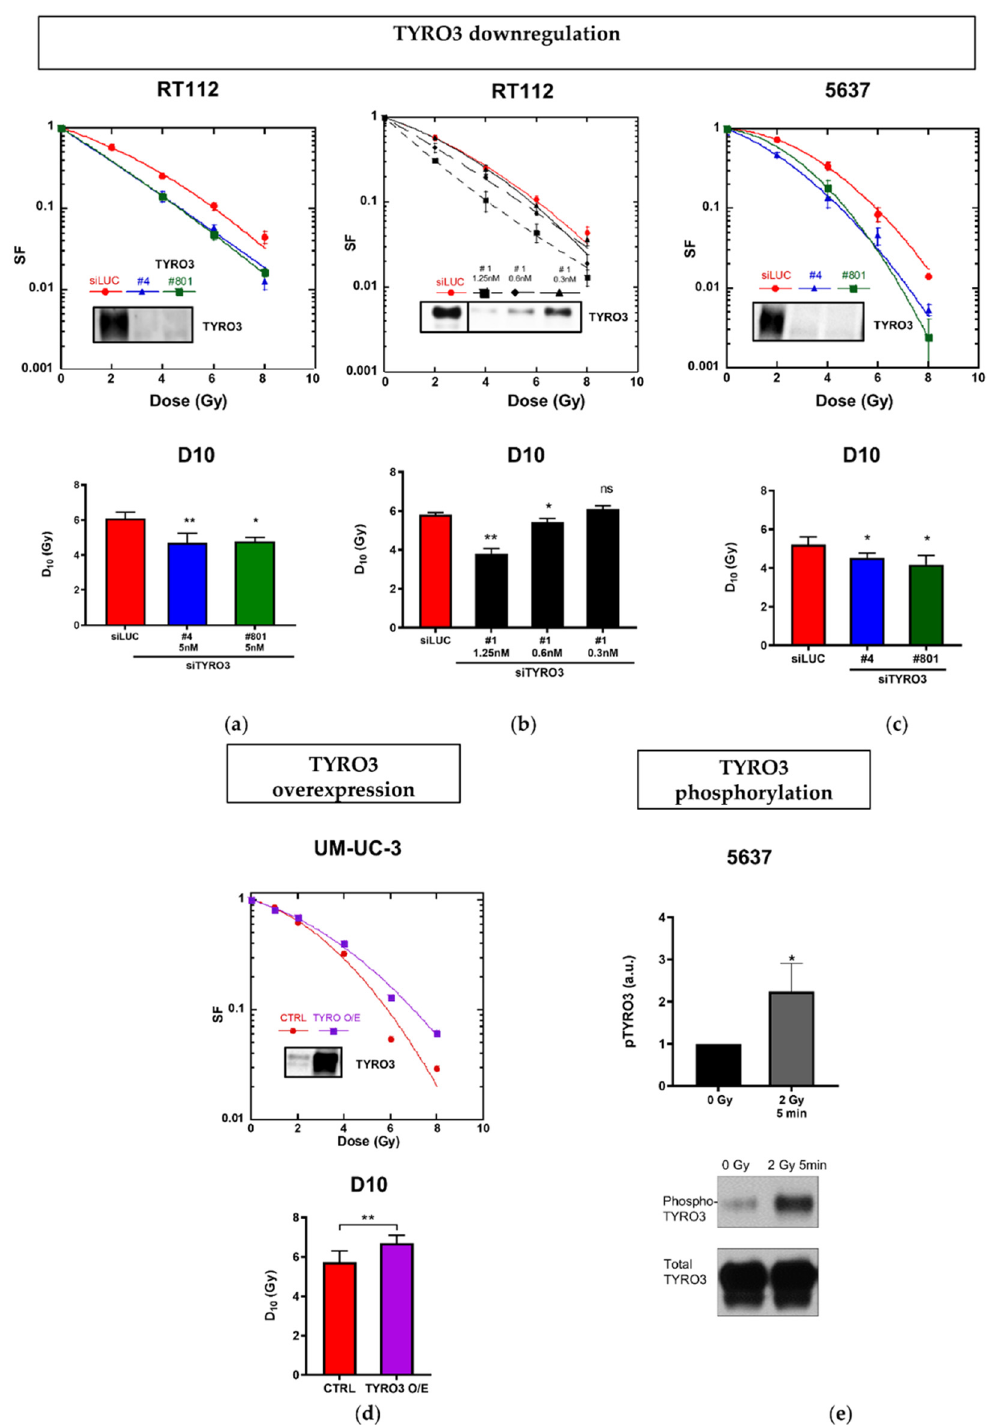
Figure 1. Impact of the modulation of TYRO3 expression on the radiosensitivity of bladder cancer cell lines. ( a – c ) Representative clonogenic survival curves of RT112 and 5637 cell lines ( upper panel). 48 h after transfection with siLUC (control, red), siTYRO3#4 (blue), siTYRO3#801 (green) or diluted concentration of siRNA#1 (black) cells were exposed to increased doses of gamma-rays. In each case, downregulation was confirmed by western blot at 48 h after transfection. The corresponding D 10 values were calculated after fitting the experimental data to the classical linear-quadratic equation ( lower panel); ( d ) Representative survival curves of UM-UC-3 control (empty plasmid, red) and TYRO3 over-expressed cell lines (TYRO3 encoding- plasmid, purple) ( upper panel). The upregula- tion was confirmed by western blot. The corresponding D 10 values were calculated after fitting the